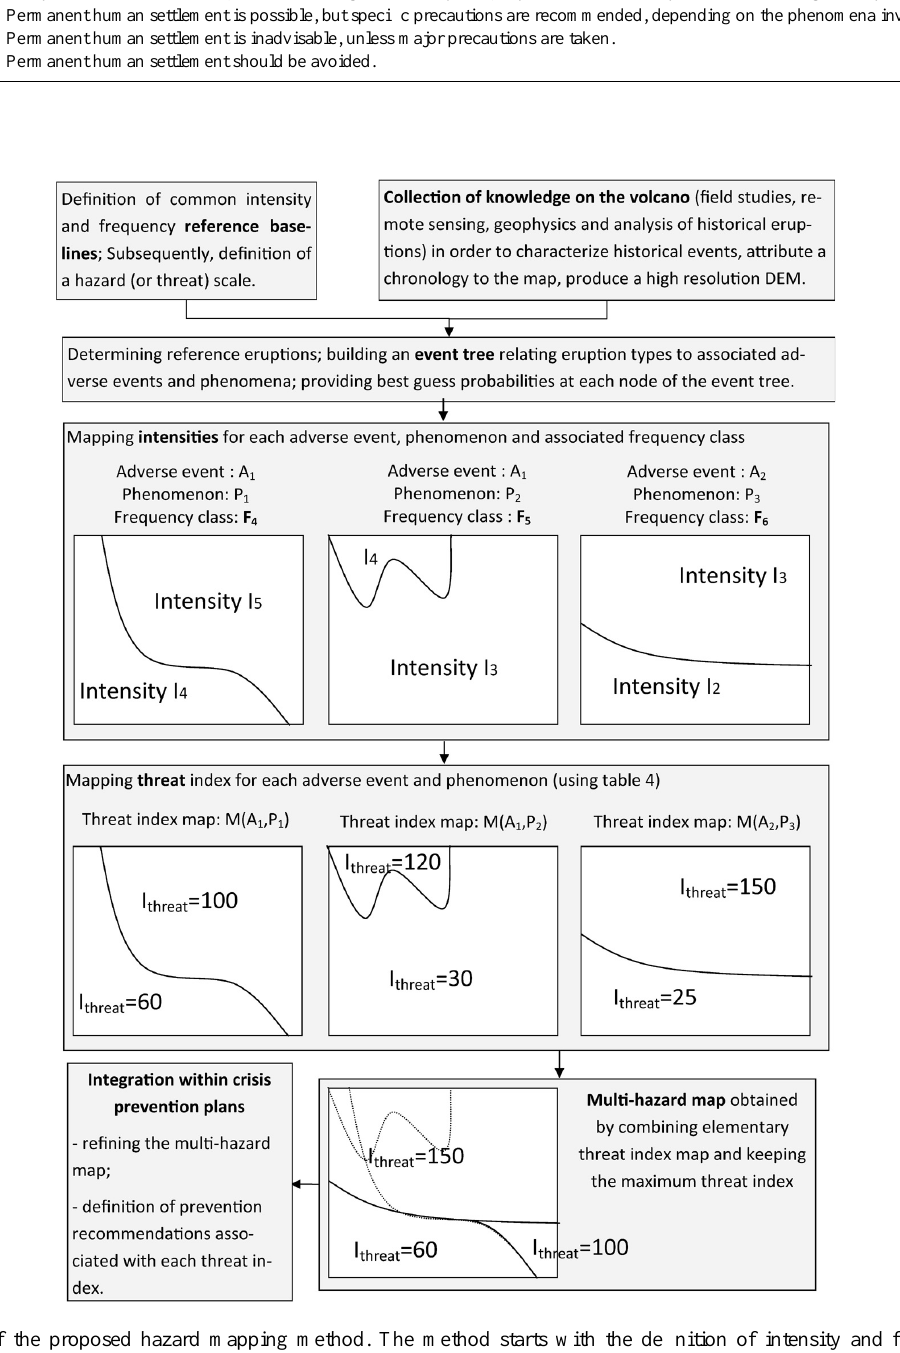
Fig. 2. Rationale of the proposed hazard mapping method. The method starts with the definition of intensity and frequency baselines (Sect. 2.1) and collection of knowledge on the volcano (Sect. 2.2). The analysis of eruption types, adverse events, phenomena and their probability of occurrence is organized around the development of an event tree; this enables mapping intensity, threat indexes and combining them within a single multi-hazard map (Sect. 2.3). In a further step, the hazard map should be integrated within risk management